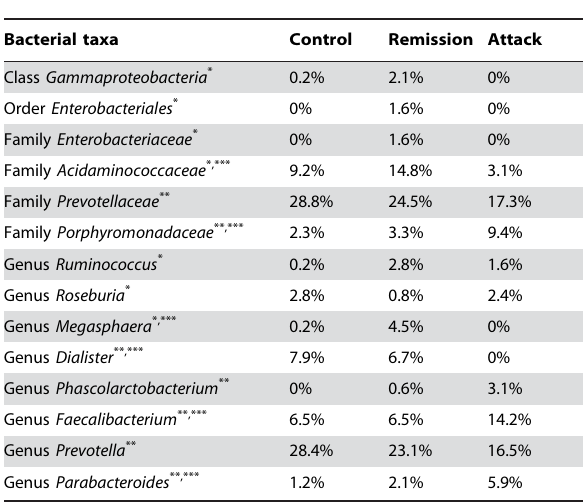
Table 3. Comparison of 16S rRNA gene libraries derived from healthy controls and FMF patients in remission and